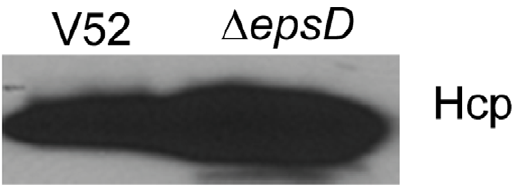
Figure 6. Type II secretion system outer membrane protein EpsD is not requited for Hcp secretion. Western blot of Hcp from the cell-free supernatant fluids of V. cholerae wild type and D epsD with anti-Hcp was